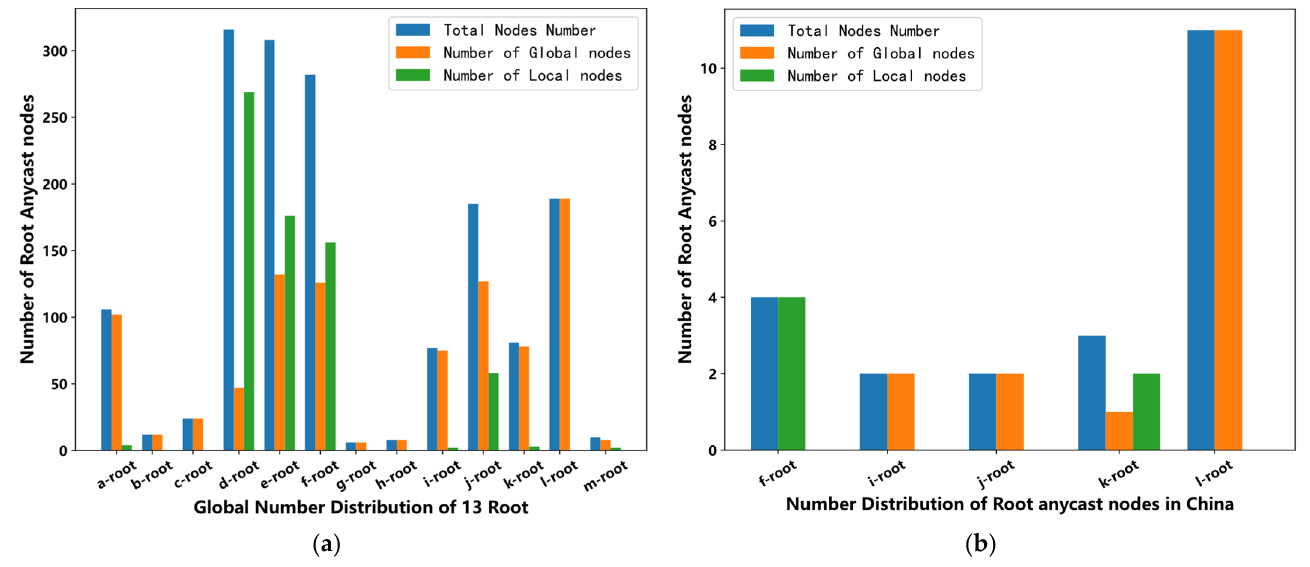
Figure 4. Global number distribution of root anycast nodes (left) and the distribution in China (right). ( a ) Global number distribution of 13 root. ( b ) Number distribution of root anycast nodes in China.